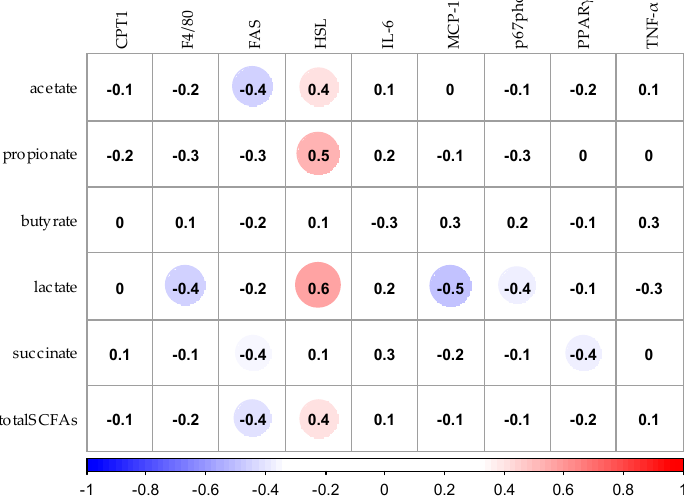
Figure 8 . Spearman’s rank correlation analysis between SCFAs and expression of mRNA related to lipid metabolism in adipose tissues. The values in the figure shows the correlation coeffcient. Blue circles show negative correlation and red circles show positive correlation. CPT1, Carnitine palmitoyl transferase 1; FAS, Fatty acid synthase; HSL, Hormone-Sensitive Lipase; IL6, Interleukin-6; MCP-1, Monocyte chemotactic protein-1; p67phox, NADPH oxidase subunit p67 phox; PPAR γ , Peroxisome proliferator-activated receptor- γ ; TNF- α , Tumor necrosis factor- α ; total SCFAs, total short-chain fatty acids.